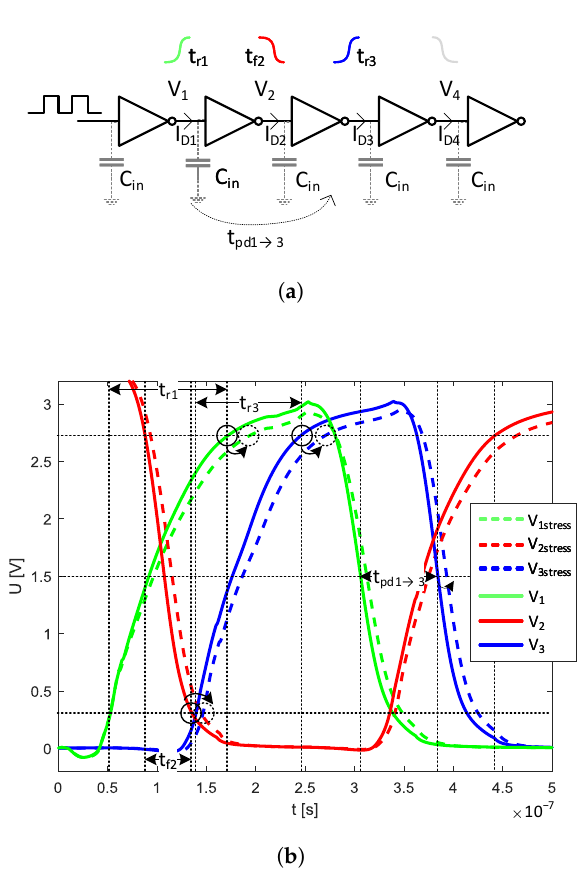
Figure 5. Explanation of the mechanical stress influence on t pd and the frequency performance of logical gates: ( a ) example circuit consisting of a five-stage cascade of inverters and ( b ) output waveforms at the corresponding inverter stages (appropriate 10%, 50%, and 90% levels are marked on the waveforms, and the example propagation delay t pd 1 → 3 between a pair of inverters). This phenomena can be used for mechanical stress measurements, where the stress- induced t r and t f changes affect the t pd of inverters connected in a ring, leading to a stress-variable frequency of oscillation. Figure 5b also shows an example of the